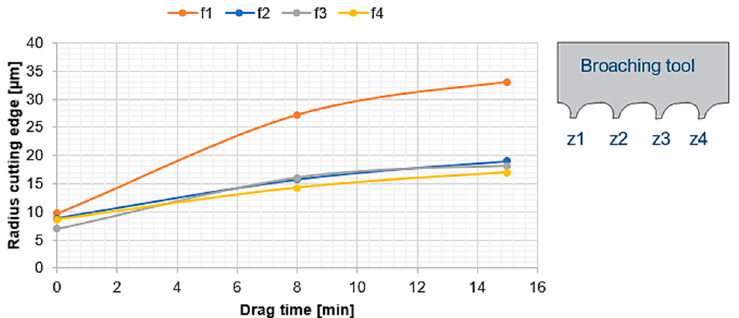
Figure 5. Results of the four cutting edge rounding of the broaching tool, drag finishing in a horizontal position.